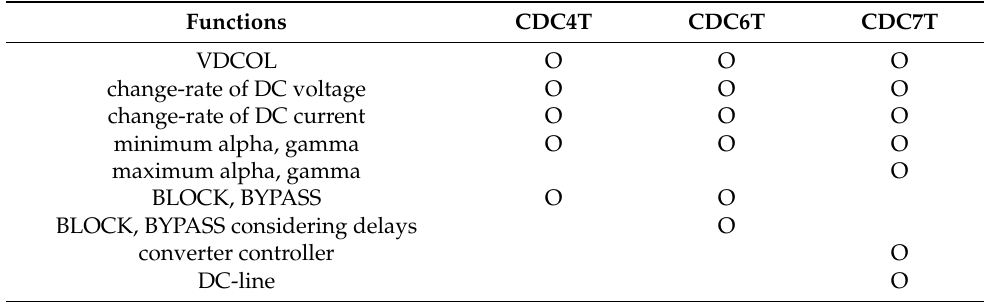
Table 4. Functions implemented in the CDC4T, CDC6T, and CDC7T to describe the HVDC system under the abnormal condition due to AC grid